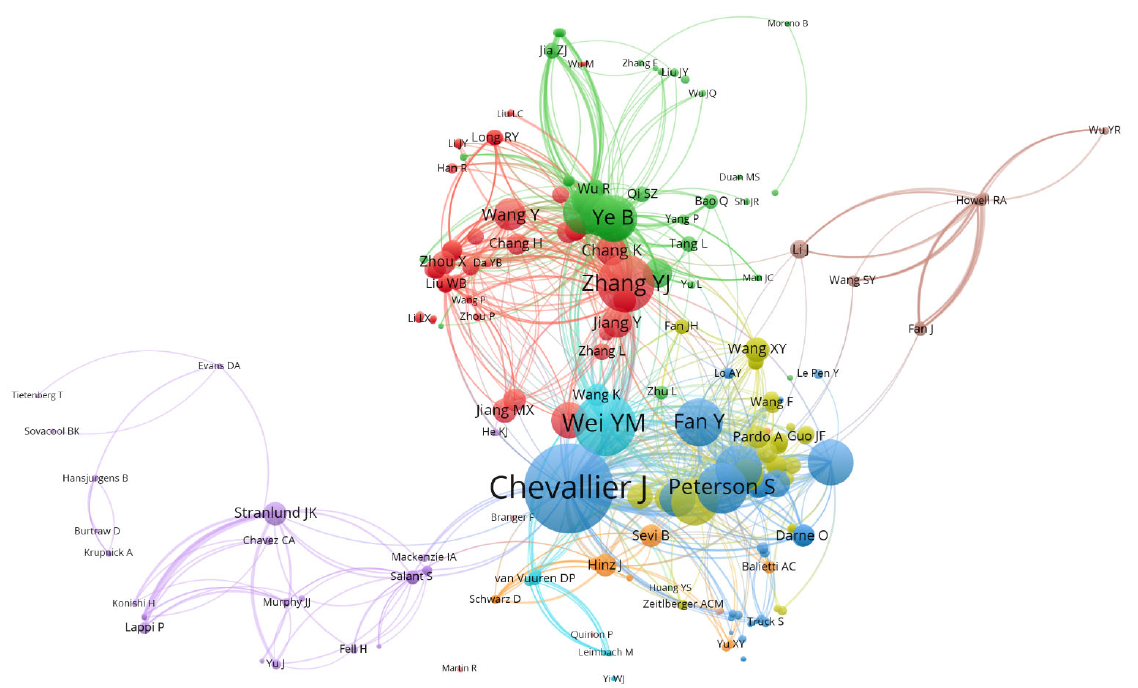
Figure 4. Bibliographic coupling by authors.